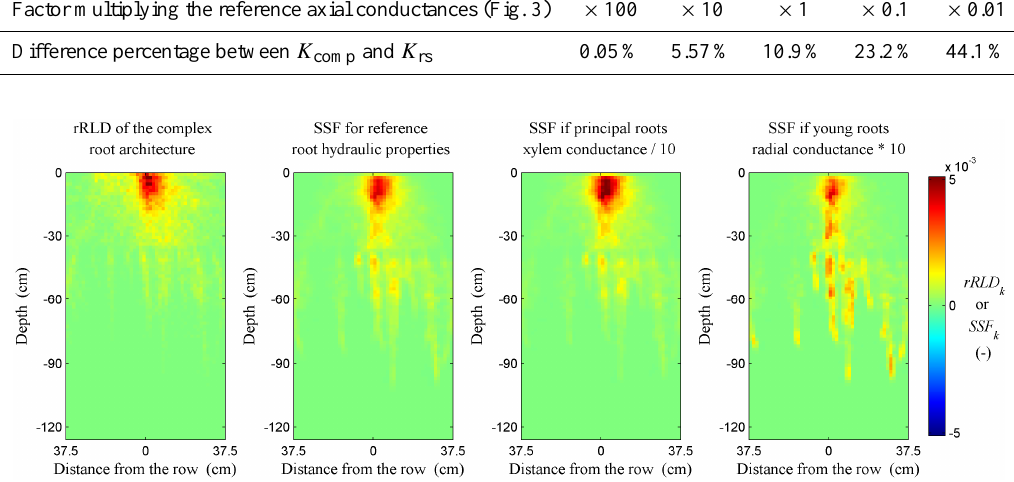
Fig. 4. Verification of the sensitivity of SSF to root hydraulic properties and comparison with the rRLD .